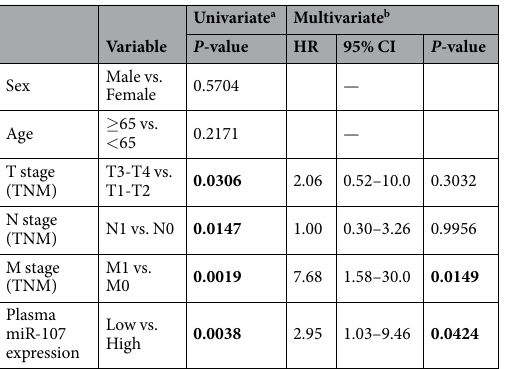
Table 3. Univariate and multivariate analyses of PCa patient survival following pancreatectomy using the Cox proportional hazards model. a Kaplan–Meier method; significance was determined by the log-rank test. b Multivariate survival analysis was performed using Cox’s proportional hazards model. HR: hazard ratio; CI: confidence interval. NOTE: significant values are in